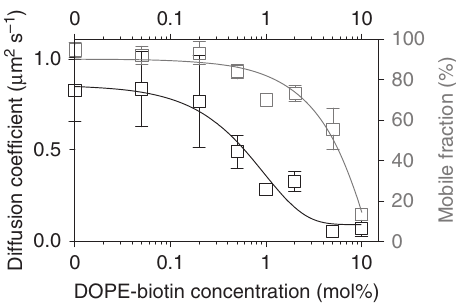
Figure 2 | Influence of varying concentrations of membrane-bound NeutrAvidin on the diffusion of VSG in supported membranes. The black squares indicate VSG diffusion coefficients and grey squares represent the corresponding mobile fractions. Trend lines are inserted as a guide for the reader’s eye. At high concentrations of non-VSG proteins (5–10% DOPE-biotin) the diffusion coefficients decrease more than 15-fold and VSG mobility is reduced to 20%. At low concentrations of non-VSG (0.1–1% DOPE-biotin) the diffusion coefficients are decreased fourfold, whereas the mobile fraction is reduced to 70%. Data are presented as means ± s.d.